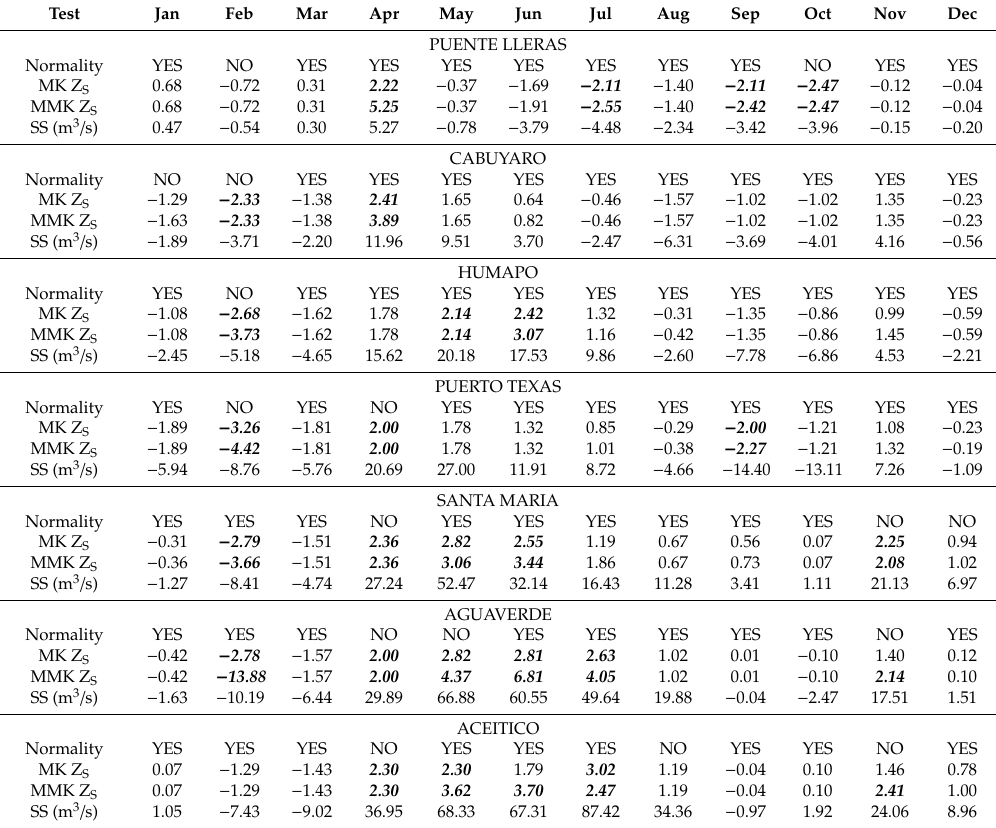
Table 2. Summary of average monthly streamflow trend test using Mann–Kendall (MK) test, the modified MK (MMK) test, and the Sen’s slope (SS) estimator in the Meta River. Test